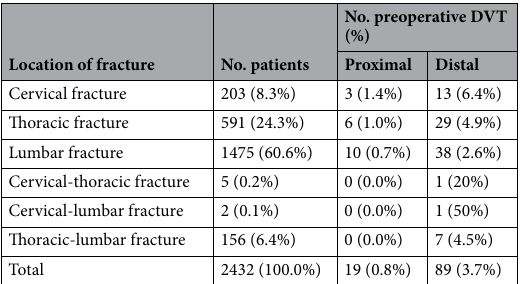
Table 1. Locations of spine fracture and preoperative incidence of DVT per